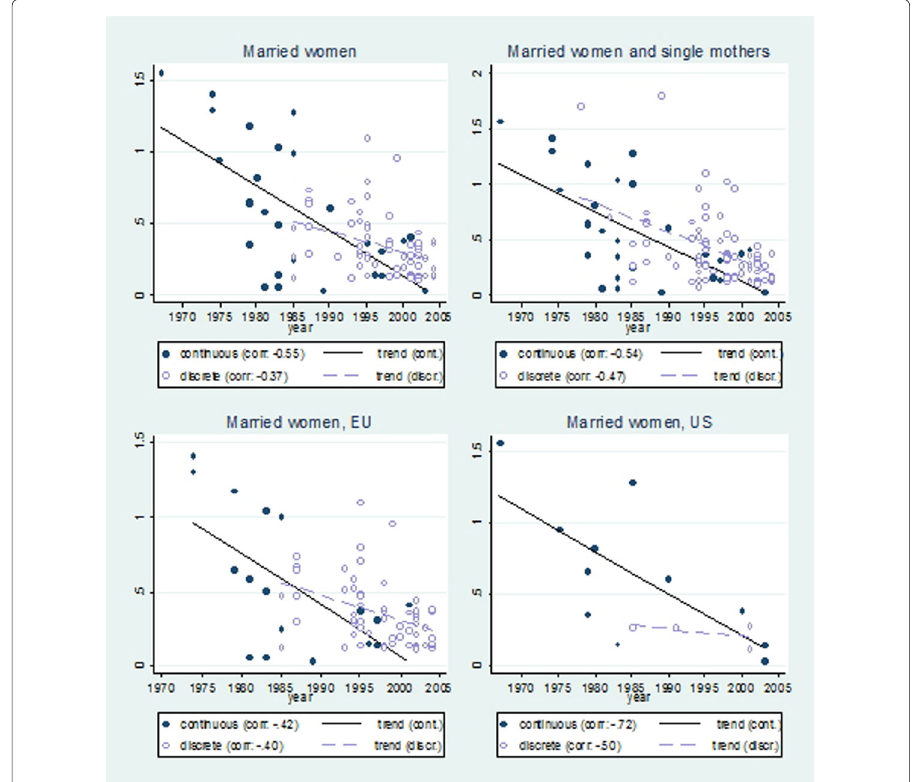
Fig. 4 Time trend in wage elasticities by broad estimation